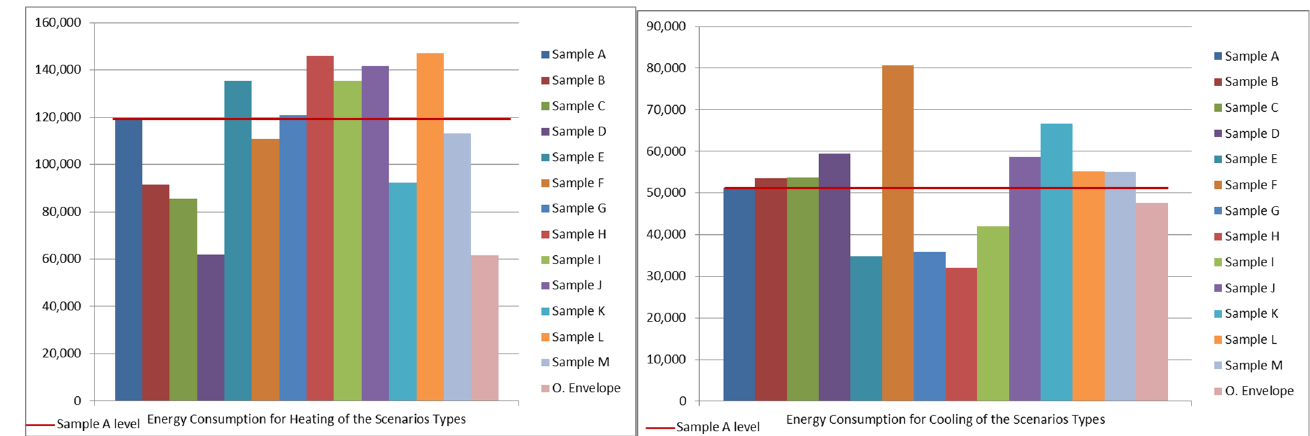
Figure 10. The HVAC system energy consumption amounts of sample mosque scenarios.